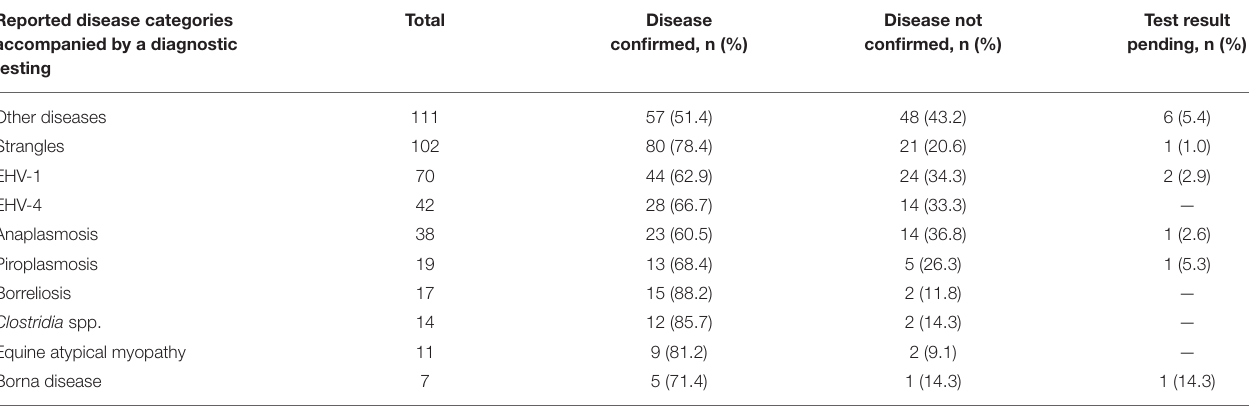
TABLE 2 | Results of the 10 most frequent diseases for which tests were submitted to Equinella between November 23, 2013, and April 26,